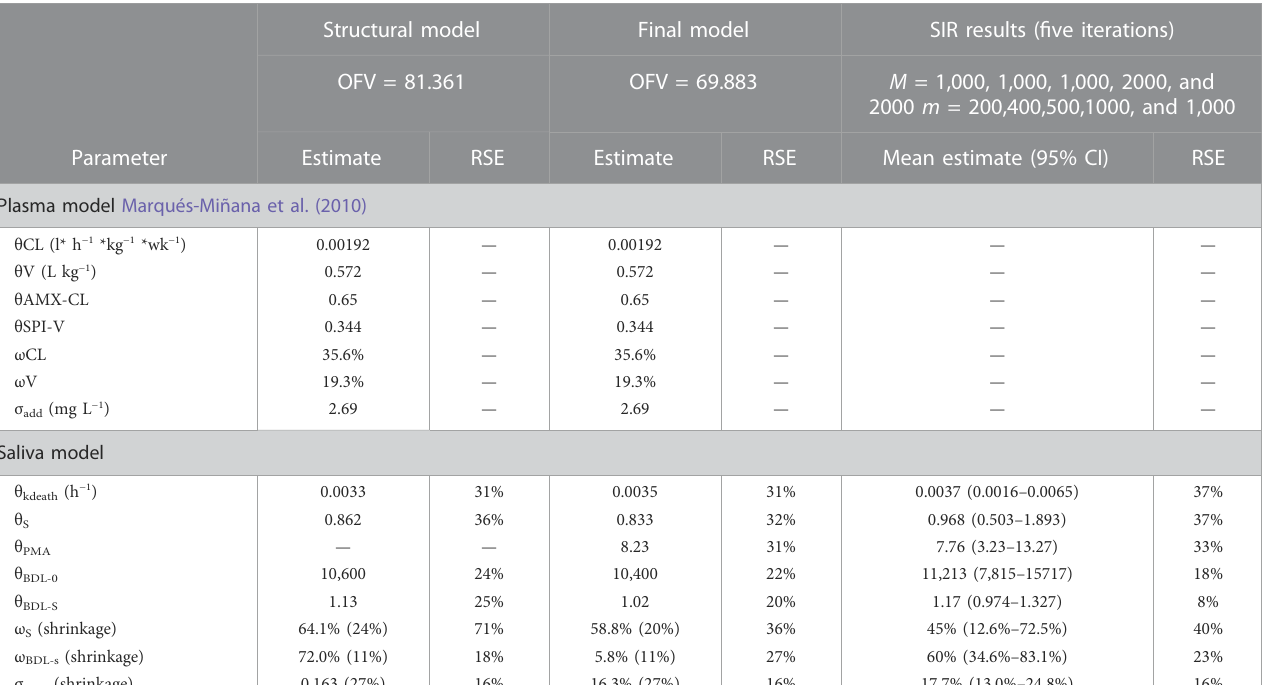
TABLE 2 Structural model, fi nal model, and SIR results for the plasma and saliva model. Structural model